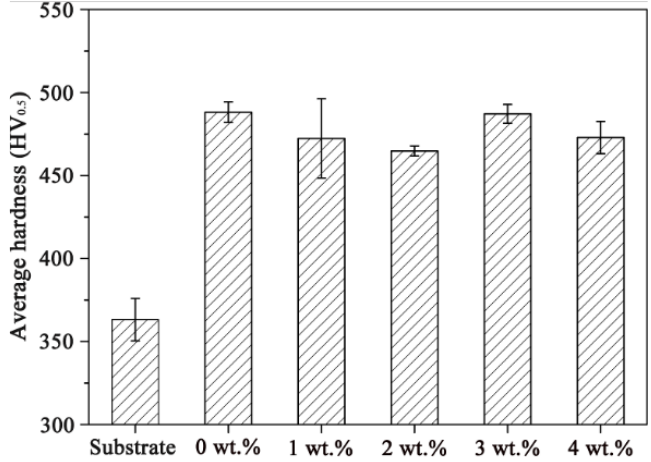
Figure 9. The average hardness of the substrate and composite coatings with various CeO 2 con- tents.